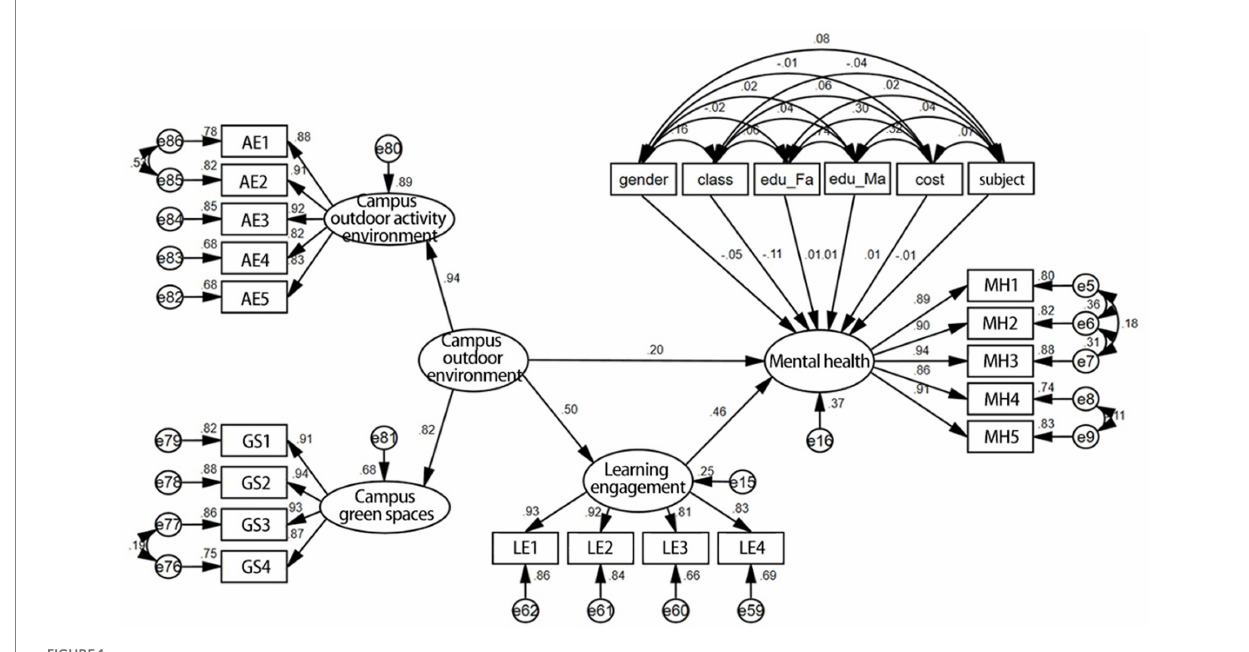
FIGURE 1 Standardized path diagram for the whole sample